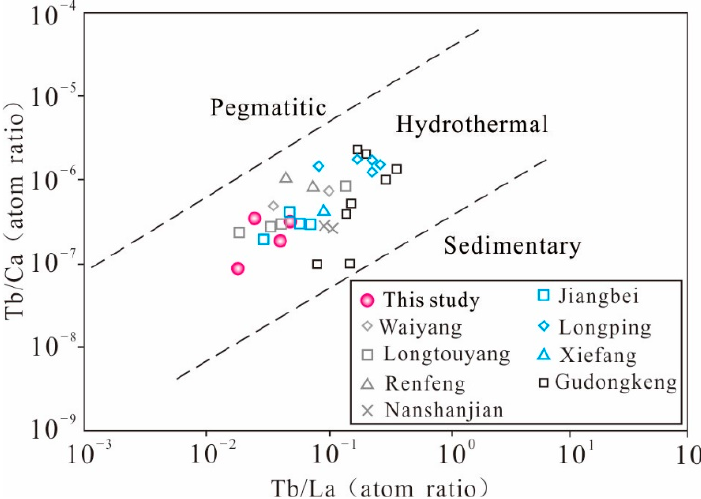
Figure 11. Tb/Ca vs. Tb/La (after [72]) diagrams of fluorites from the Shuanghuajiang fluorite deposit. Data source: The Shuanghuajiang fluorite deposit is from this study; other deposits are after [15,52,74].